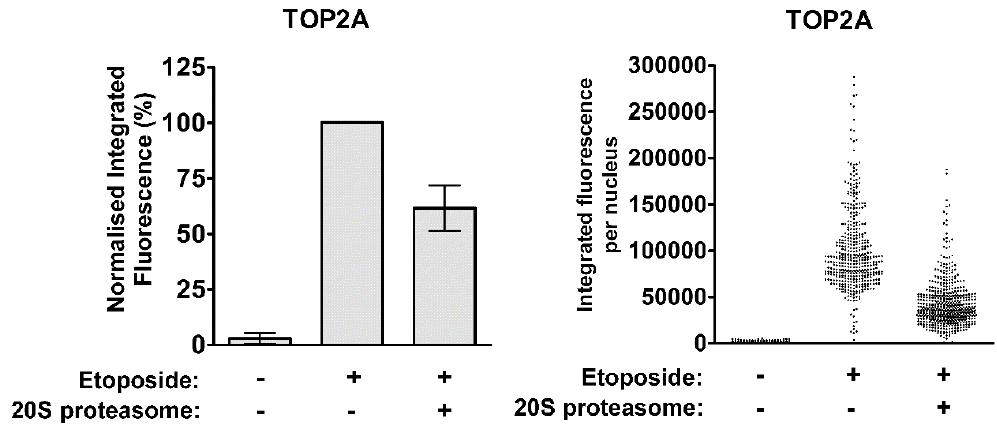
Figure 2. Incubation of TARDIS slides with 20S proteasomes. TARDIS slides prepared from etoposide-treated K562 cells were treated with 1 µg 20S proteasome preparations. After 90 min, remaining TOP2A-DNA covalent complexes were detected by quantitative immunofluorescence. All fluorescence values were normalised to the values obtained following exposure of cells to 100 µM etoposide and subsequent incubation in preparation buffer without 20S proteasomes. Data is presented as the normalised mean of medians ± SEM (histogram) and raw integrated fluorescence values from a single experiment before normalisation (scatter diagram).